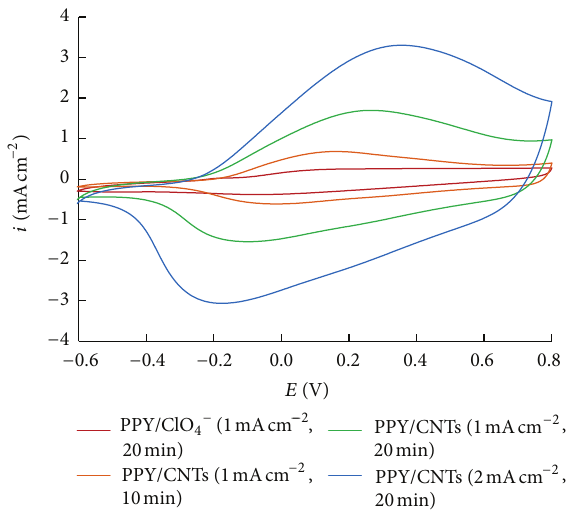
Figure 3: CVs in 0.1M LiClO 4 in propylene carbonate of the PPY/CNTs composite films compared with the pure polymeric ones galvanostatically obtained at different charge